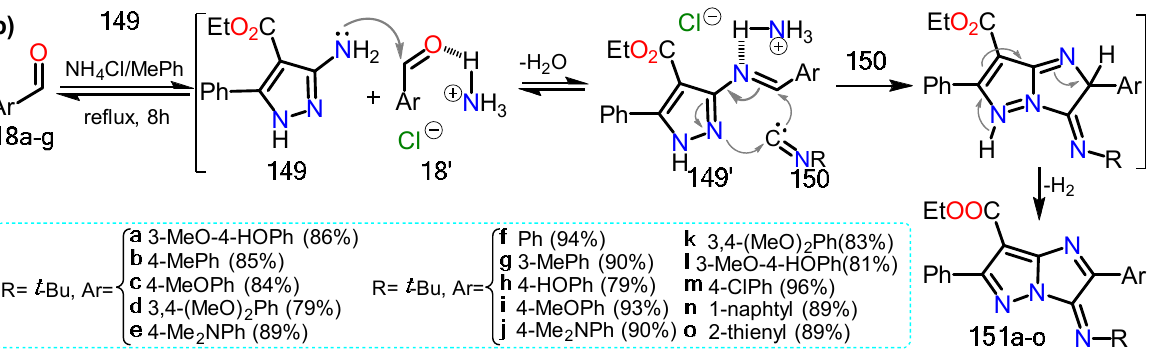
Scheme 23. Synthesis of 1 H -imidazo[1,2- b ]pyrazole derivatives ( a ) 145–148 and ( b ) 151 . Precursor 144 was selectively brominated with NBS producing the 7-bromo substi- tuted derivative 145 , which was used as a substrate in the reaction with i- PrMgCl · LiCl, forming the magnesiated intermediate 145 (cid:48) that then reacts with varios electrophiles (i.e., S-methyl sulfonothioate, tosyl cyanide, and TESCl) and by transmetallations to give 146a–i . Notably, the authors found that using CuCN · 2LiCl or Pd(PPh 3 ) 4 as a catalyst allows the allylation or acylation/arylation on 146j (cid:48) , respectively, obtaining crosscoupling products with electron-rich and electron-deficient groups. Products 146a–I were submitted to a se- lective magnesiation on C3 using TMPMg · LiCl (via 147b (cid:48) ), and various reaction